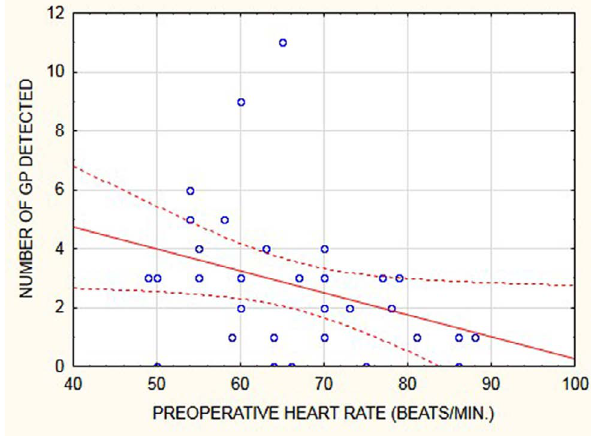
Fig. 2 - Correlation between the number of GP detected and preoperative heart